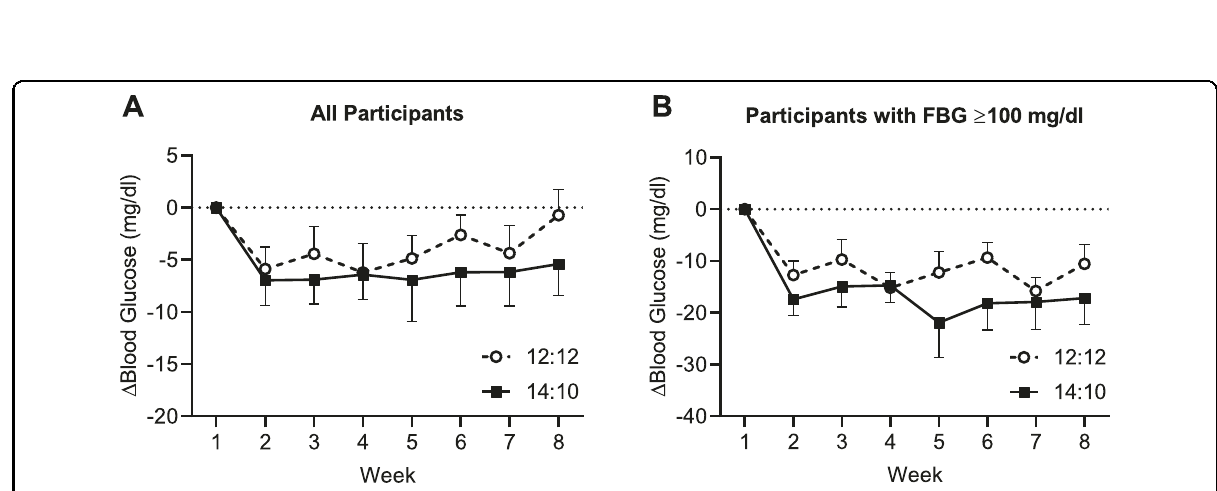
Fig. 3 Change in fasting blood glucose in study completers. A Change in FBG for all participants. Data are mean ± SE for the completer population ( n = 30). B Change in FBG for participants with baseline levels ≥ 100 mg/dl. Data are mean ± SE for participants in the completer population with a baseline FBG of ≥ 100 mg/dl ( n = 12/group). FBG fasting blood